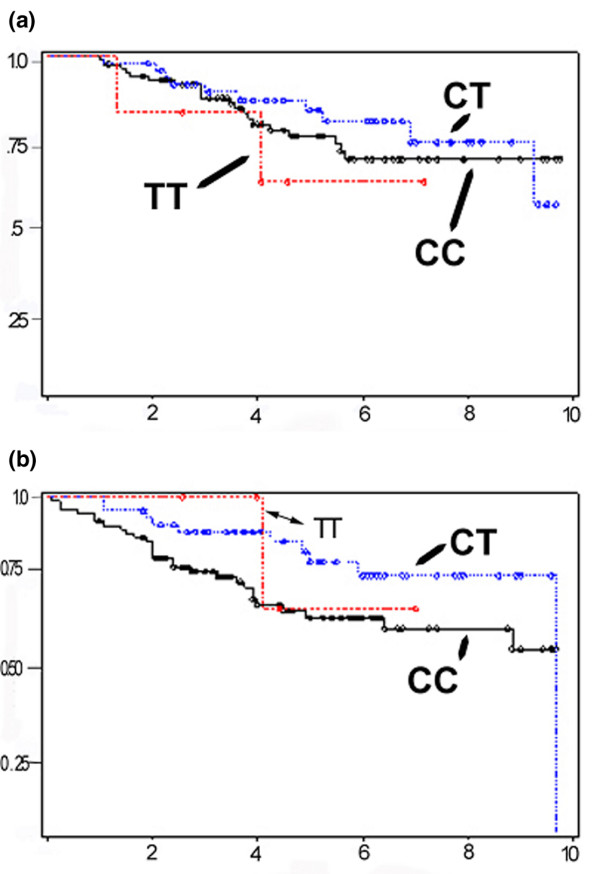
The manganese superoxide dismutase -102 genotype: (a) percentage overall survival and (b) percentage recurrence-free survival by years of follow-up with radiation therapy. CC, homozygous wild-type genotype; CT, heterozygous for variant genotype; TT, homozygous variant genotype.